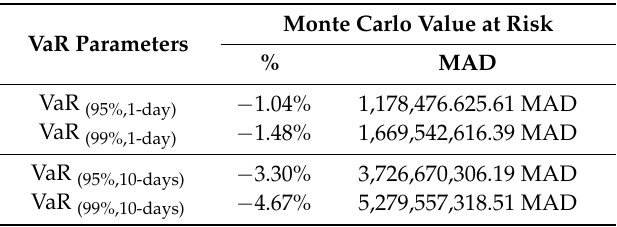
Table produced on Excel under VBA by the